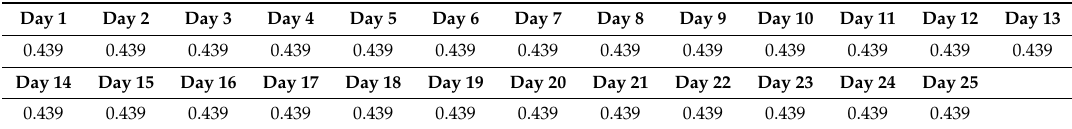
Table 6. Standard deviation ( σ normal ) values of normal